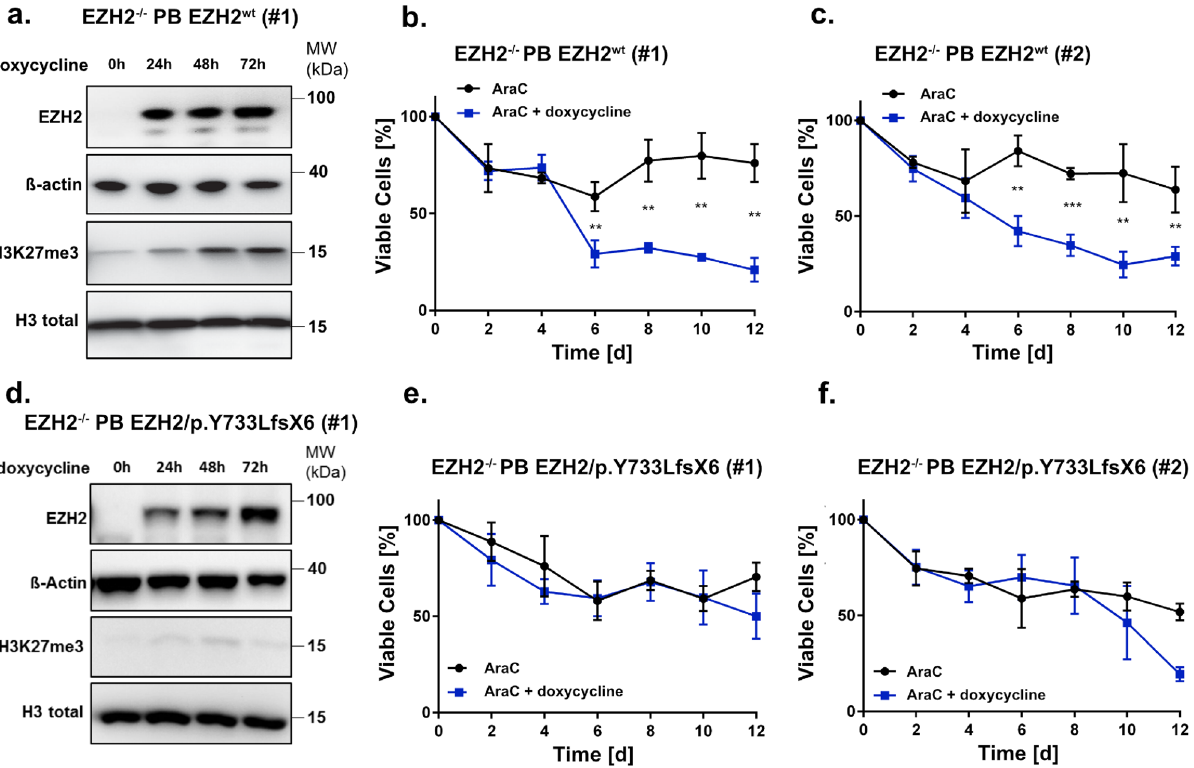
Figure 5. EZH2 re-expression sensitizes K562 cells to AraC treatment. (a,d) Immunoblot for EZH2 expression and global H3K27me3 in (a) EZH2 −/− PB EZH2 wt cells (clone #1) and (d) EZH2 −/− PB EZH2/p.Y733LfsX6 (clone #1) after 0 h, 24 h, 48 h and 72 h of doxycycline induction. Cells were treated with 1 µg/ml doxycycline every 24 h. MW, molecular weight; β-actin and H3 total, loading controls. (b–c, e–f), AraC low dose long-term treatment in (b–c) EZH2 −/− PB EZH2 wt and (e–f) EZH2 −/− PB EZH2/p.Y733LfsX6 cells. Cells were pre-treated for 3 d with doxycycline and then treated with 30 nM AraC/DMSO for 12 d. Cells were split and treated every 4 d and doxycycline was added every 48 h to ensure stable expression of EZH2. Error bars indicate mean ± s.d of three independent experiments. Unpaired, two-tailed Student’s t-test; * p < 0.05; ** p < 0.01; *** p < 0.001.